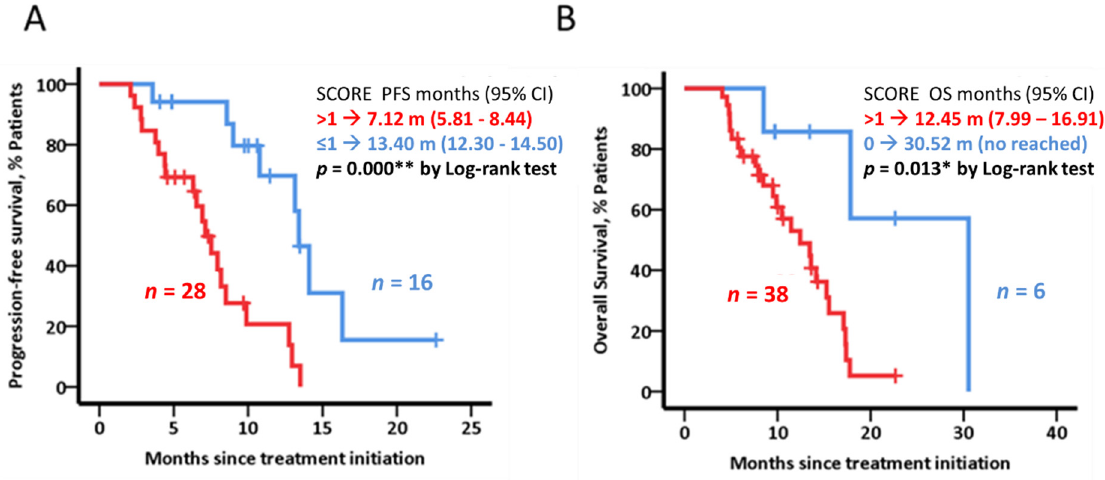
Figure 1. PFS and OS KM curves based on different cytokine score in BL patients ( n = 44). ( A ) Kaplan–Meier plot represents PFS dichotomized depending on the points given by four cytokine levels, one point was given when cytokine levels were associated with worse PFS, 0 points (blue) between one and four (red). ( B ) The same as ( A ) for OS and dichotomized depending on the points given by four cytokine levels. In the text, PFS or OS and 95% CI values are shown. Log-rank test was used to test for statistical significance. * and ** in the figures indicate significant ( p < 0.05) and very significant ( p < 0.01) statistical differences.